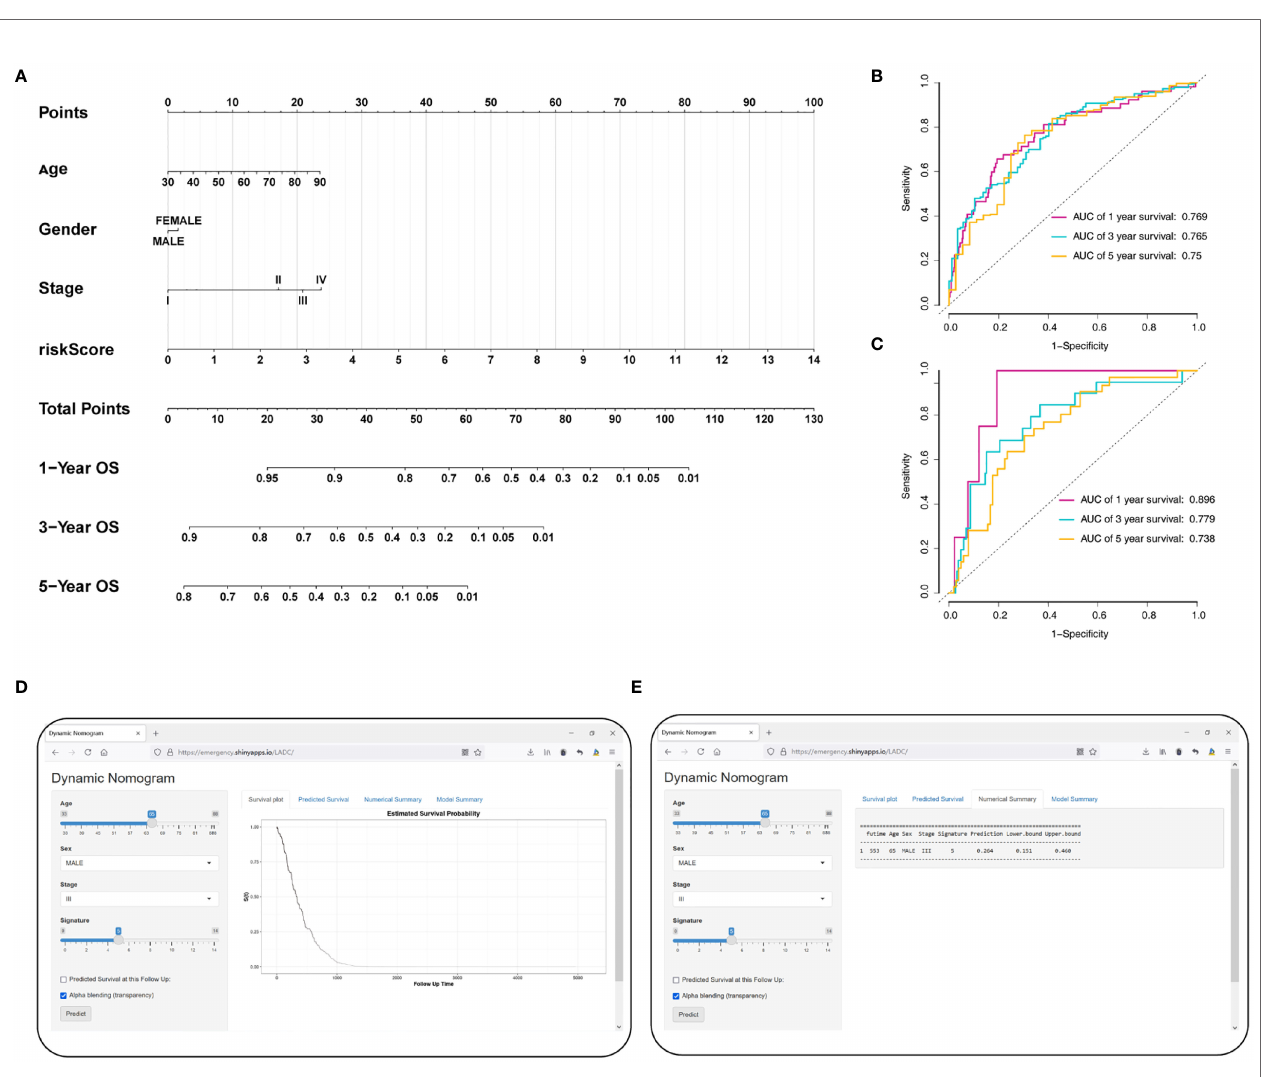
FIGURE 9 | Construction of the MRG-based nomogram. (A) Development of MRG nomogram. (B) Time-dependent ROC curve analysis for 1-, 3-, and 5-year overall survival predictions obtained using the nomogram in the training set. (C) Time-dependent ROC curve analysis for 1-, 3-, and 5-year overall survival predictions obtained using the nomogram in the validation set. (D) Establishing an easy-to-operate web-based calculator for predicting the overall survival of LADC (https:// emergency.shinyapps.io/LADC/). (E) 95% con fi dence interval of the web overall survival